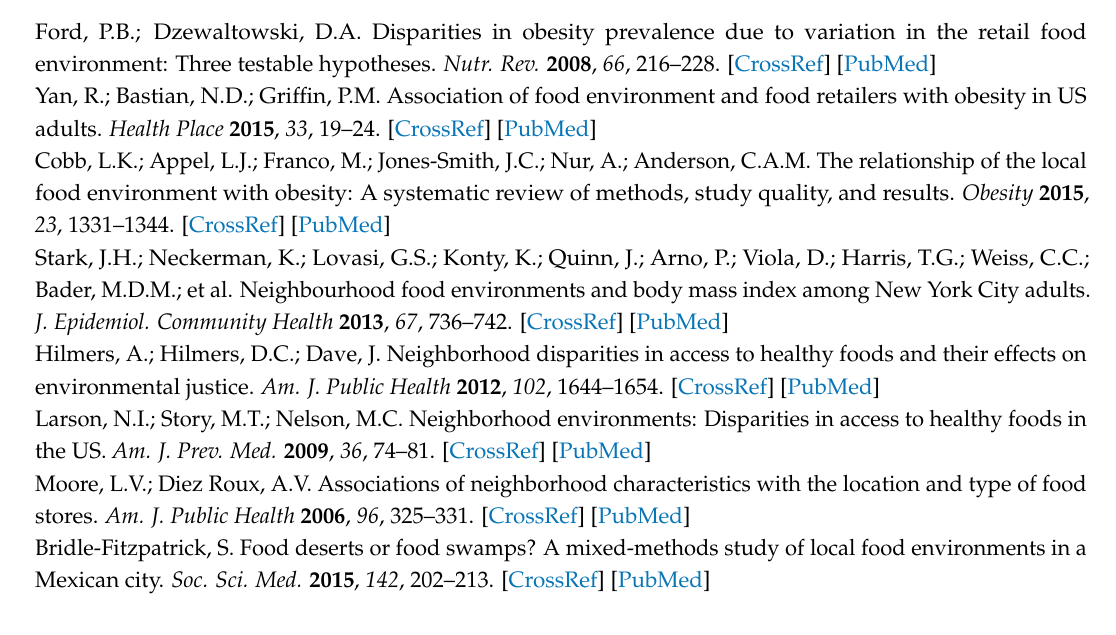
Table S1: Each of 175 SIC definitions classified into one of 10 crude food outlet categories. Table S2: Keywords used to identify and tag dollar stores and carry-out restaurants. Table S3: Top 50 fast food chain restaurants in the U.S, reported by the leading source of information for the quick-service industry, QRS Magazine (Available at: https://www.qsrmagazine.com/reports/qsr50-2015-top-50-chart). Table S4: Average median sales price of homes of CSAs, according to neighborhood SES and proportion of the neighborhood population that is African American. Table S5: Neighborhood fixed effects linear regression for the relationship between changes in vacancy rates and changes in the food swamp index in Baltimore, MD, over the study period from 2001 to 2012, excluding CSA 52 and CSA 53 from 2001 through 2009. Results are from the pooled model and stratified models by African American neighborhoods and neighborhood SES. Table S6: Global Moran’s I statistic for the regression residuals, over the study